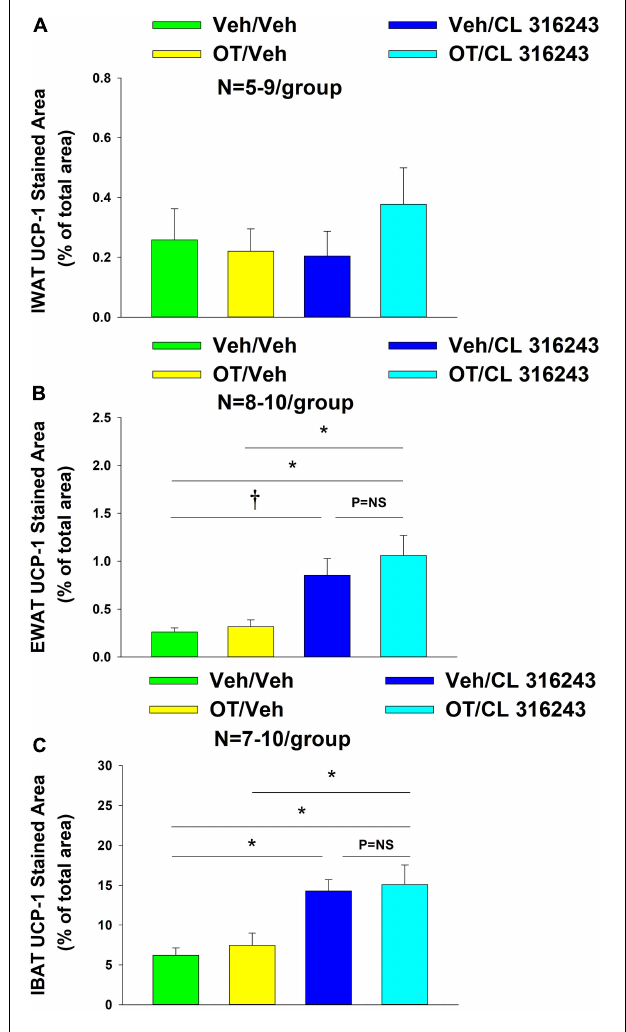
systemic beta-3 receptor agonist (CL 31643) administration (0.5 mg/kg) on UCP-1 content in IWAT, EWAT, and IBAT in male DIO rats. UCP-1 was analyzed from IWAT, EWAT, and IBAT (A–C) in DIO rats treated with 4V OT (16 nmol/day) or 4V vehicle in combination with IP CL 316243 (0.5 mg/kg) or IP vehicle. (A) IWAT. (B) EWAT. (C) IBAT. Data are expressed as mean ± SEM. * P < 0.05, † 0.05 < P <